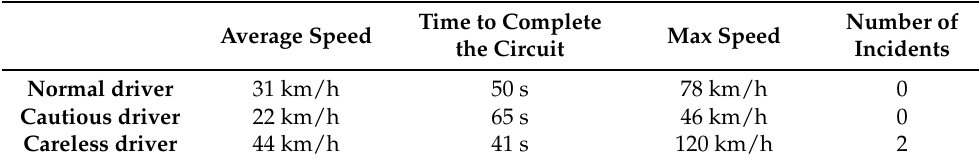
Number of Max Speed Incidents